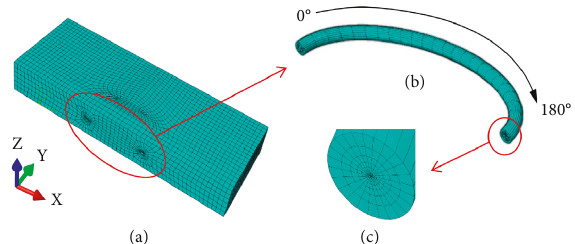
Figure 4: Finite element mesh model. (a) Global model. (b) Re- fined crack front meshes. (c) Front surface of crack front meshes.